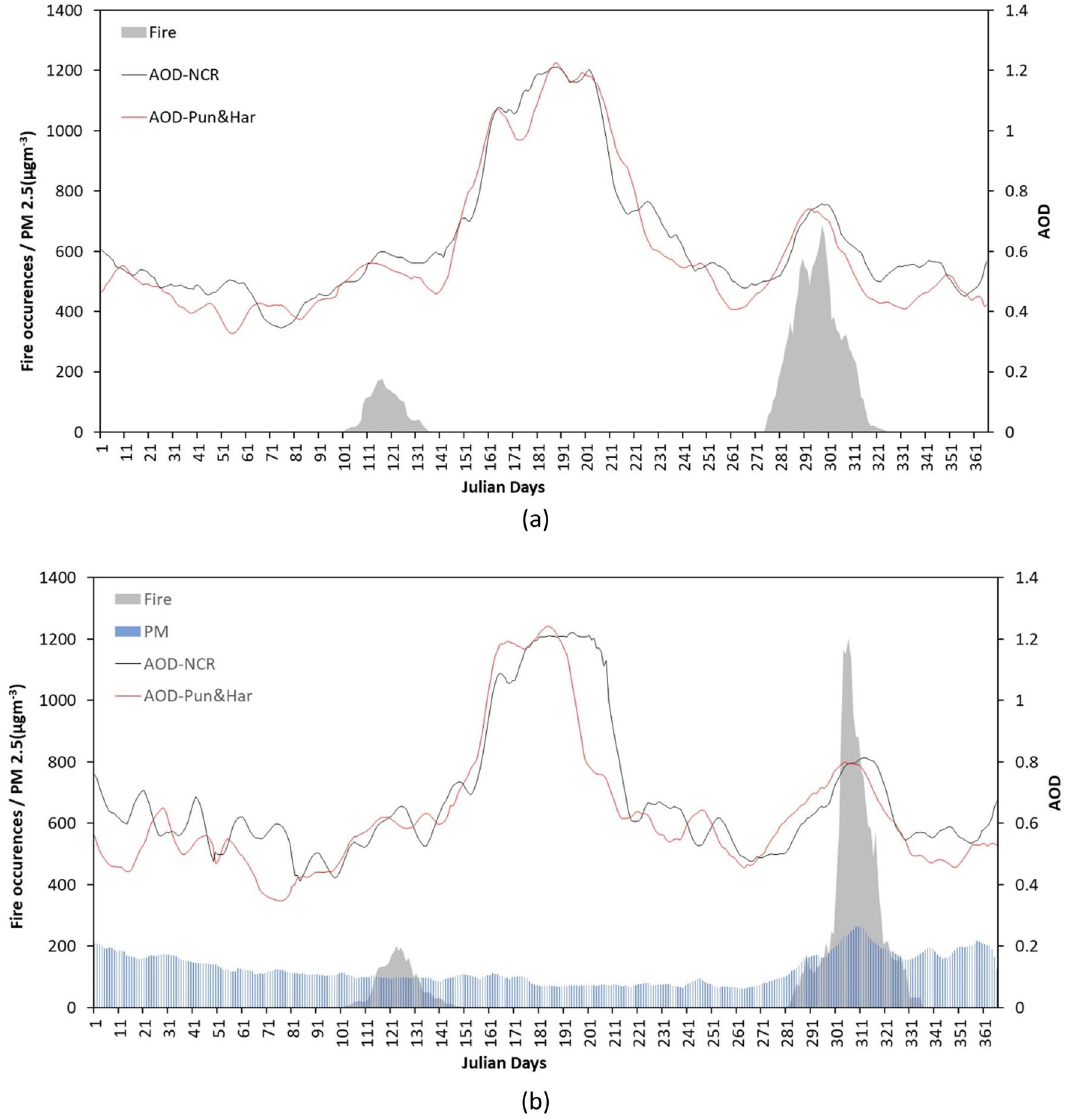
Figure 5. Daily average AOD and PM 2.5 over NCR and Fire counts over Punjab and Haryana during 2002– 2010 ( a ) and 2011–2020 ( b ) (PM 2.5 data is from 2010–2020) (High AOD over NCR during summer monsoon is attributed to thin and moving clouds prevailingduring the